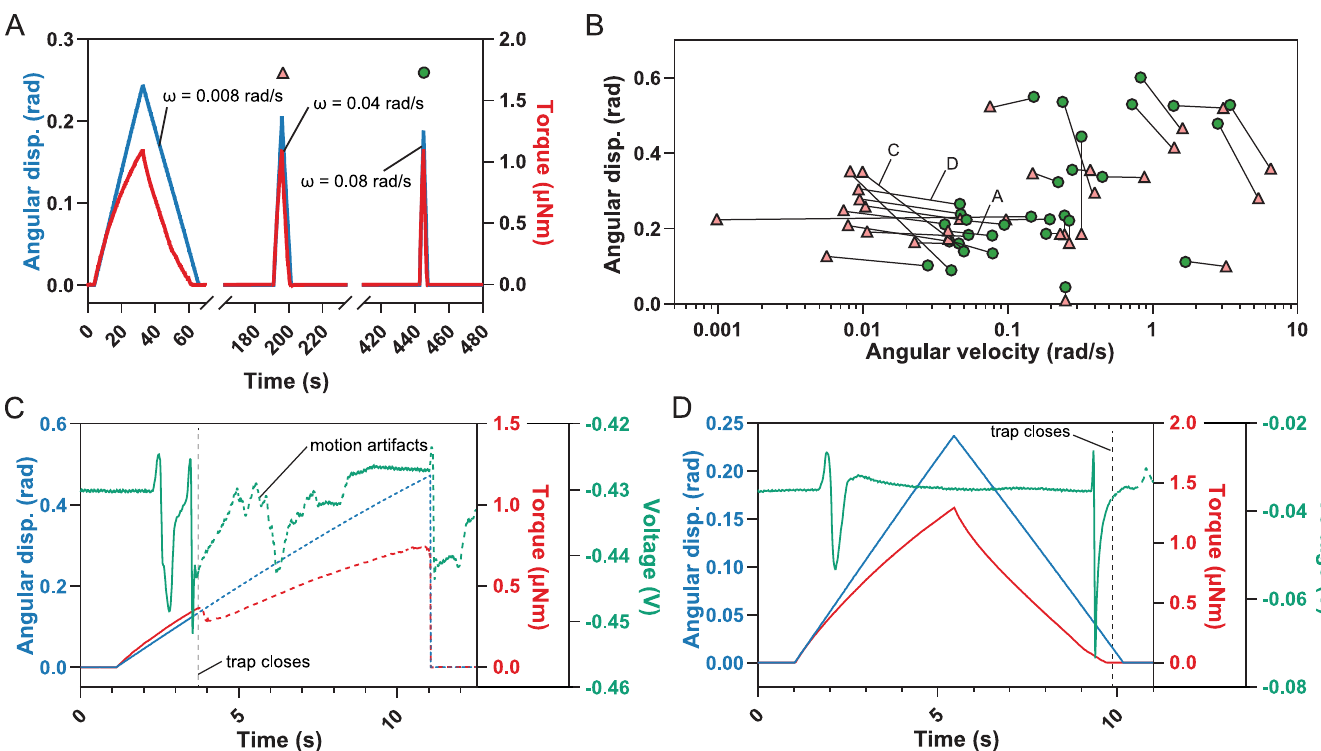
Fig 4. Slow single deflections lead to trap closure. (A) Successive single displacements (“disp.”) of the sensory hair with increasing angular velocity while the torque is recorded. (B) Individual single-deflection experiments showing the stimulus that initiated trap closure (green circles) and the preceding, nontriggering deflection (red triangles). The specific experiments shown in (A), (C), and (D) are indicated. (C and D) Single deflections at an intermediate velocity that led to trap triggering where either (C) two APs were generated during bending (on the way in), or (D) one AP is fired at the beginning of bending (on the way in) and a second at the end of the return (on the way out). Only the data up to the start of the trap closure were used. The data affected by motion artifacts are indicated by dotted lines. For the underlying data, see sheets Fig 4A to Fig 4D in S1 Data. AP, action potential.